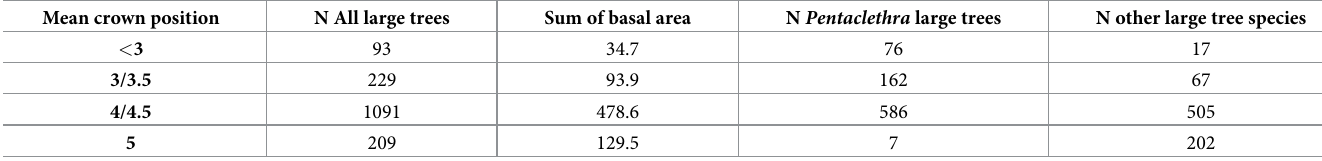
Table 4. Large trees crown position and basal area.